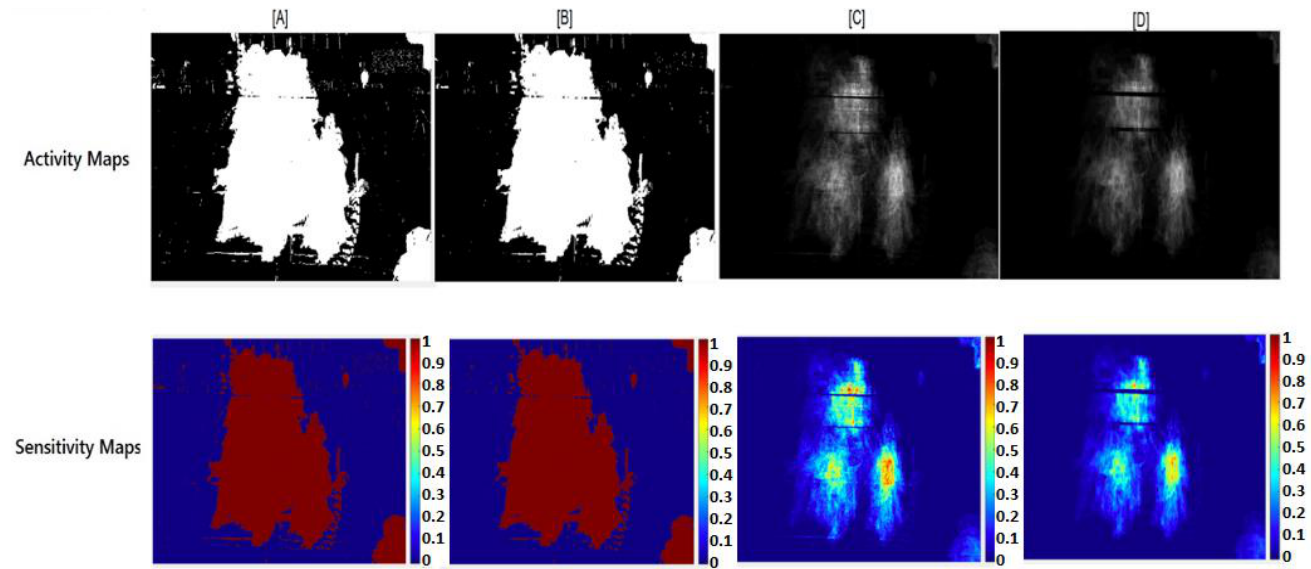
Figure 10. Simulation results from video dataset 4 by the proposed framework (( a ) extracted frames in grayscale, ( b ) foreground by adaptive background subtraction post-binarization and ( c ) optical flow).